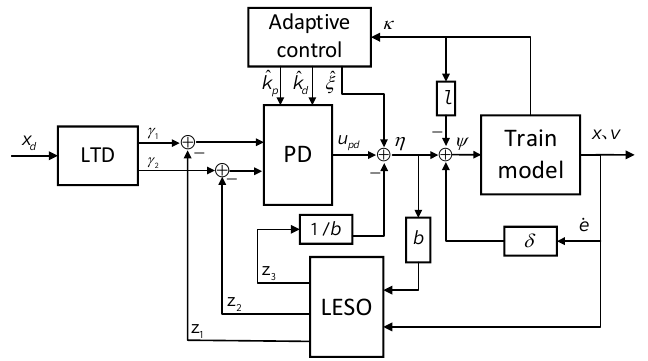
Figure 3. ALADRC control structure diagram.